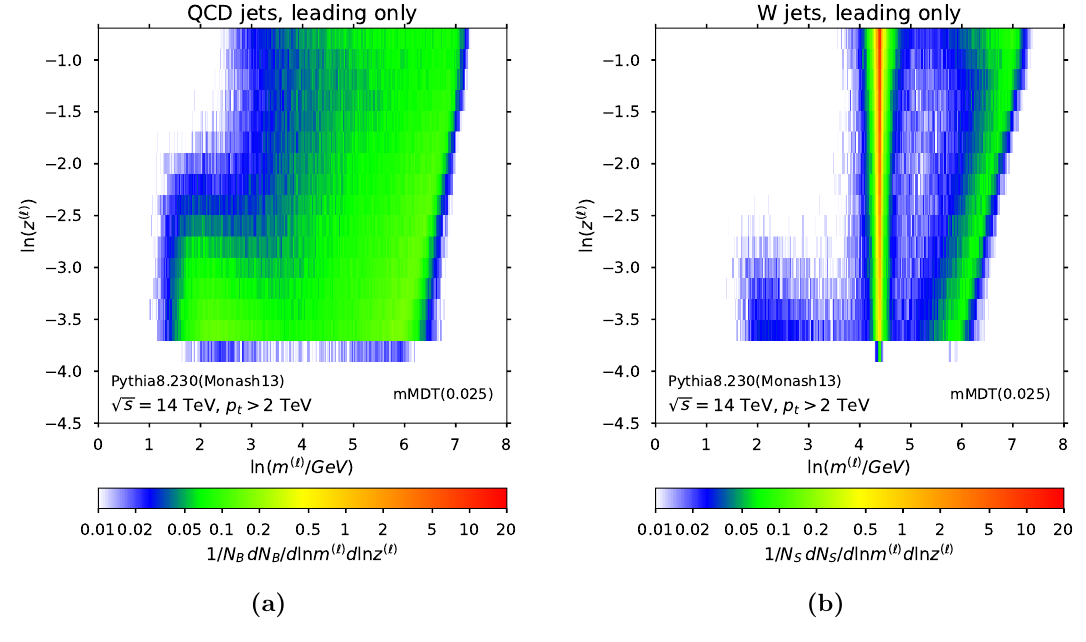
dN X for (a) background QCD jets N X d ln m ( ‘ ) d ln z ( ‘ )